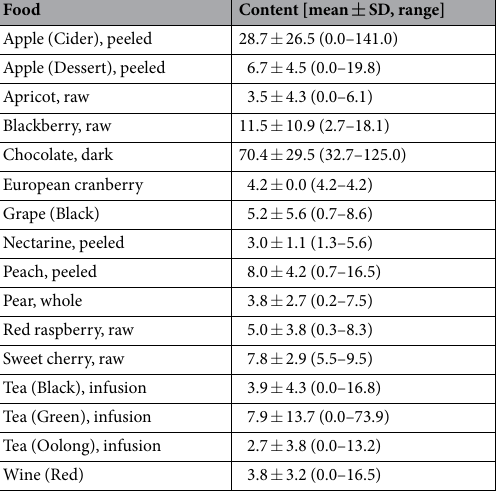
Table 1. Ranges of ( − )-epicatechin content (mg/100 g or mg/100 mL) of different foods commonly consumed (data from Phenol Explorer 3.0 37